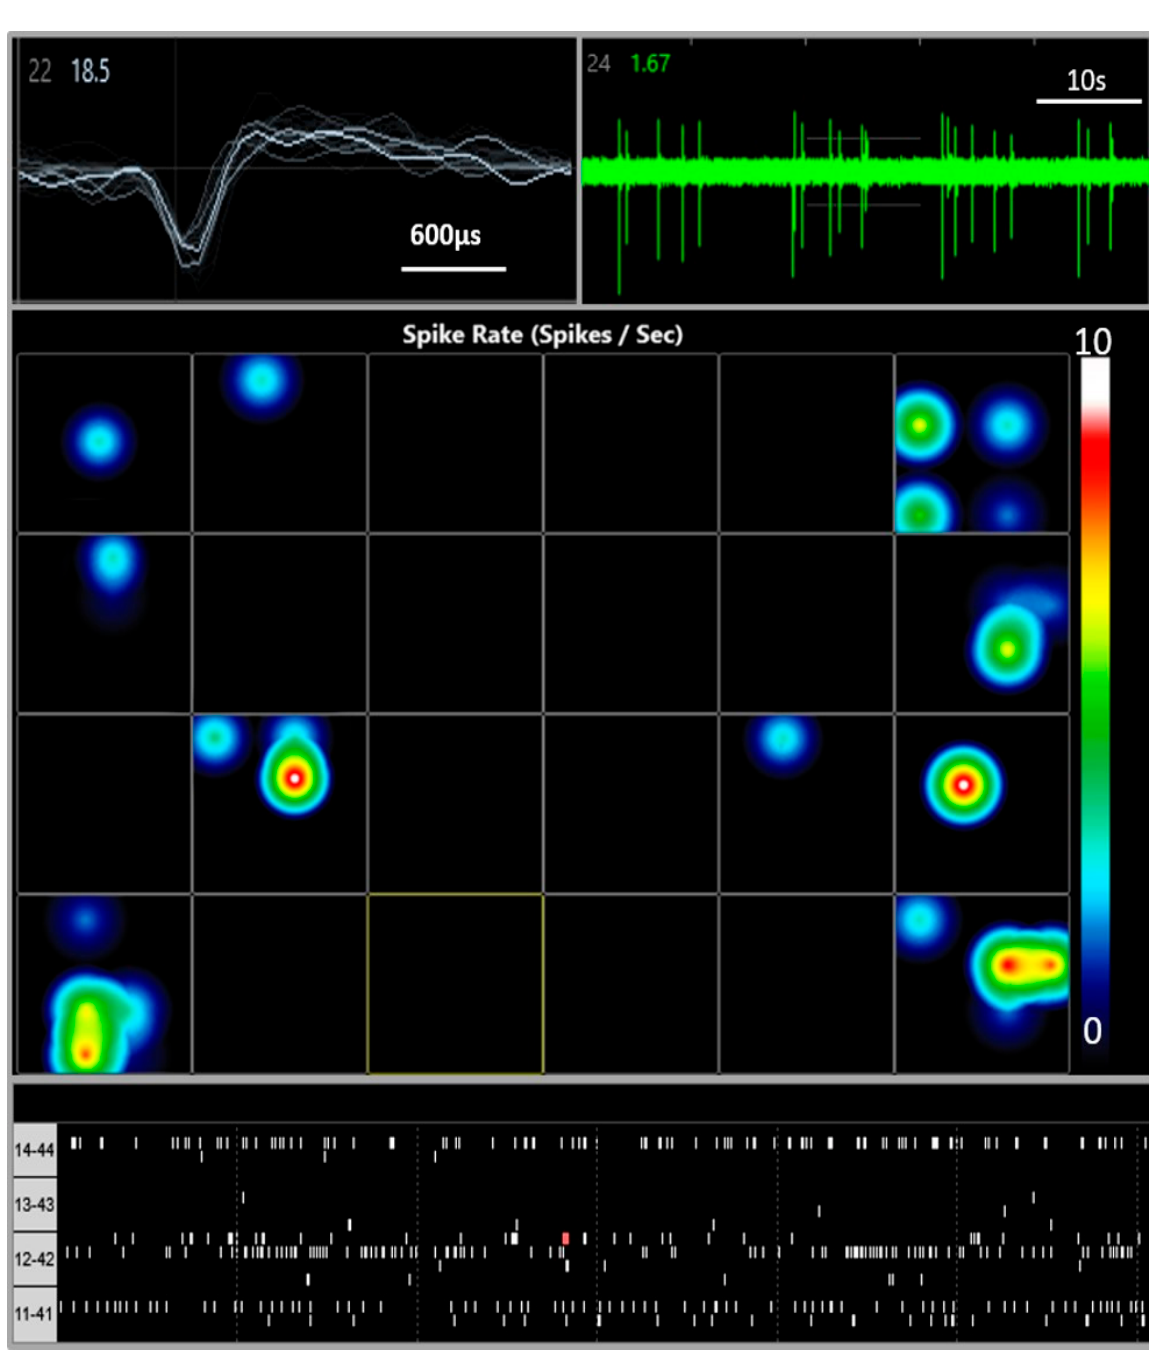
Figure 2. Multi-Electrode Array (MEA) recordings from iCell neurons. Top left shows extracellular voltage trace from an active electrode. Top right corner shows spike activity over baseline noise. Center panel is a color-coded heat map with a snapshot from a 24 well plate with blue indicating lower (circa 1Hz) spike frequency and red/white high (10Hz) activity. The bottom panel is a Raster plot showing individual electrodes and spike frequency at day 8 post-plating (with the electrode numbers shown on the left side).